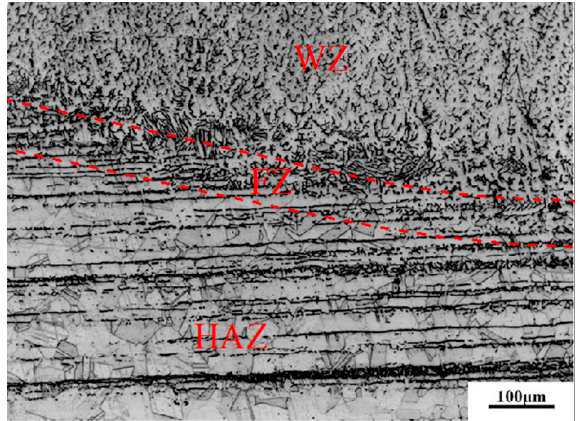
Figure 6. Metallographic structure of whole repair welding joint.